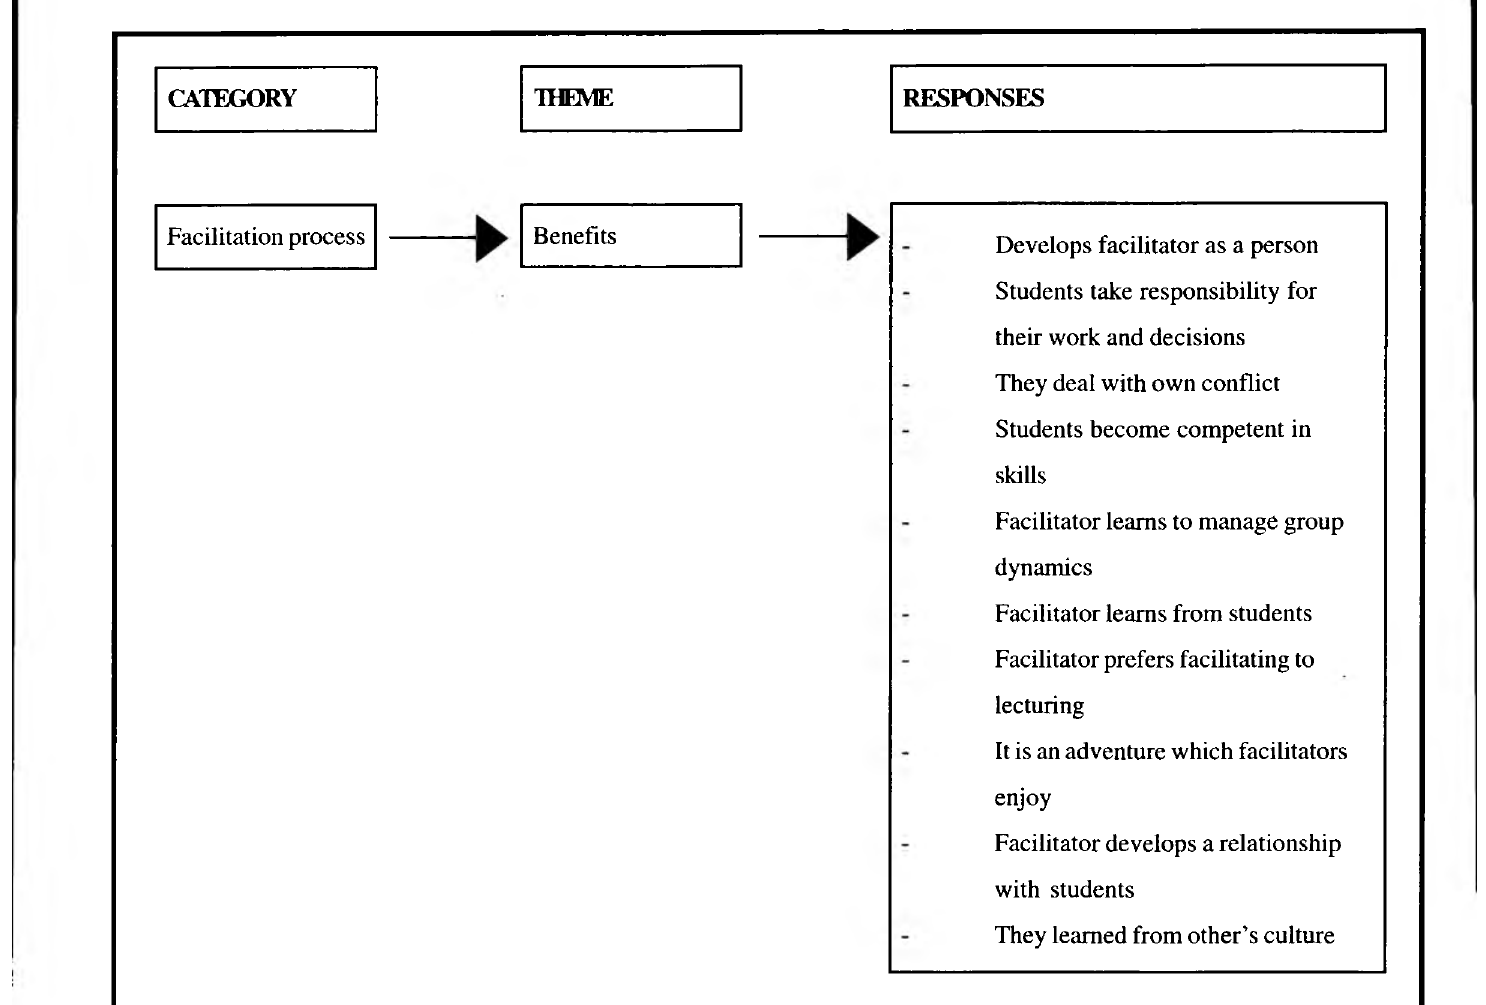
FIGURE 1.5: Benefits of facilitation